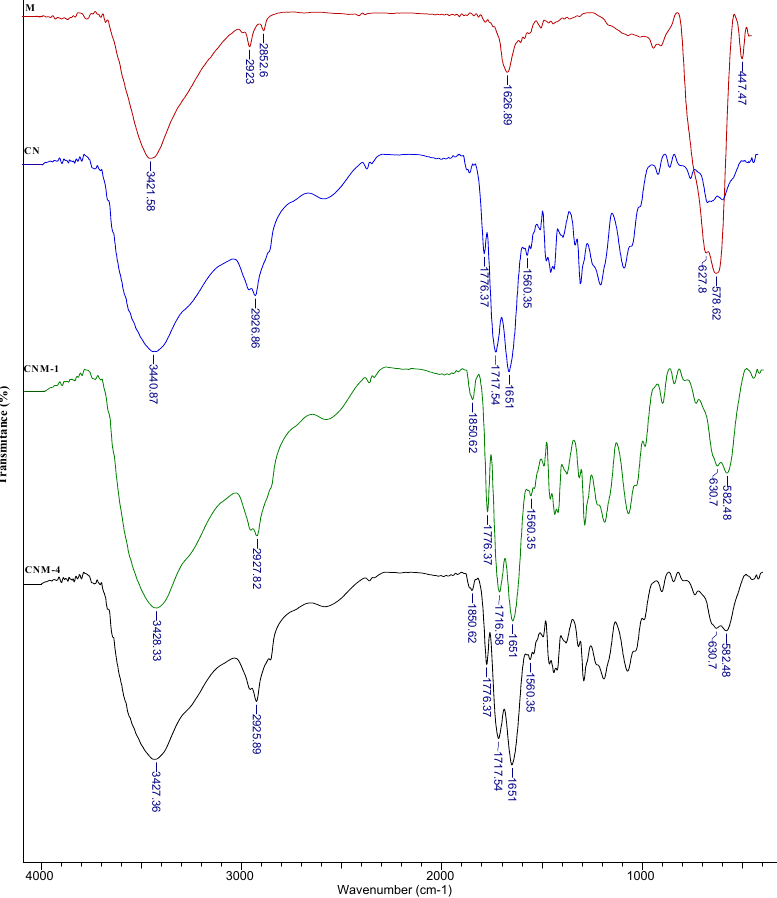
Figure 2. FTIR spectra for magnetite (M), CN, CNM-1, and CNM-4.